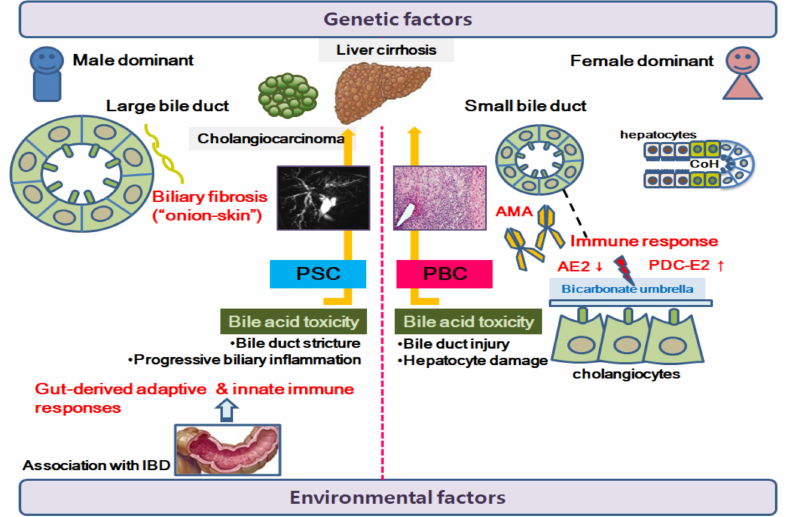
Figure 1. The comparison between PBC and PSC. This is a figure highlighting the differences between two diseases. The picture is adapted from Gidwaney et al. [254] and Libre Pathology (https://librepathology.org, accessed on 28 April 2022). CoH: canals of Hering, PSC: primary sclerosing cholangitis, PBC: primary biliary cholangitis, IBD: inflammatory bowel disease, AMA: anti-mitochondrial antibody, AE2: anion exchanger 2, PDC-E2: pyruvate dehydrogenase complex,